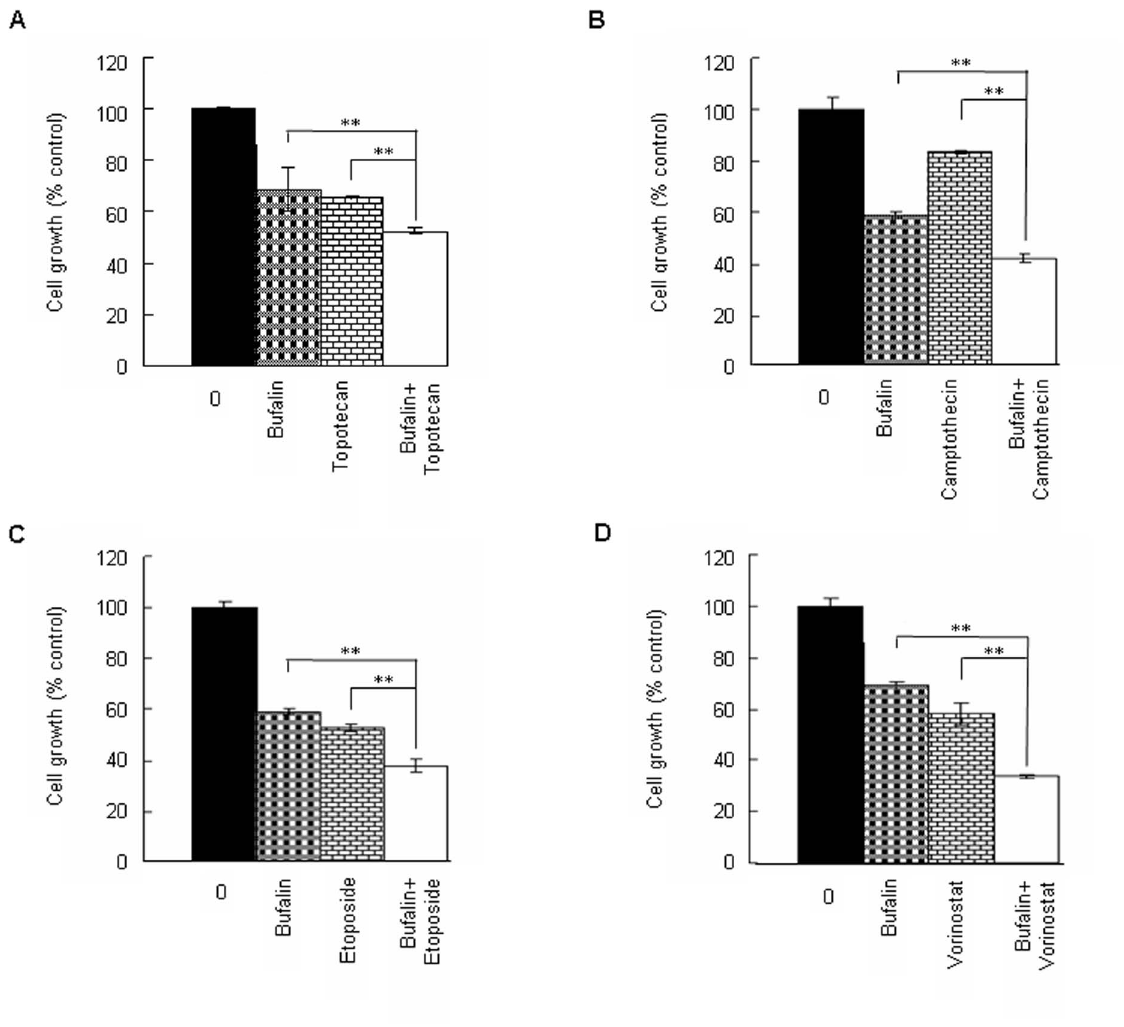
Figure 6. Bufalin enhances chemosensitivity of H929 cells. (A–D) H929 cells were treated with 10 nM bufalin alone, or in combination with 50 nM topotecan, 10 nM camptothecin, 2.5 m M etoposide, and 0.5 m M vorinostat, respectively for 48 h. Cell proliferation was measured by CCK8 assay. All values represent means 6 S.D. of three independent experiments, each performed in triplicate (.** P , 0.01, compared to single drug treatment).